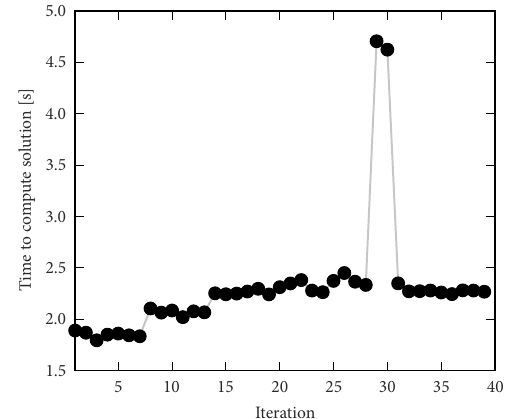
Figure 6. Time taken per iteration: real-time testing